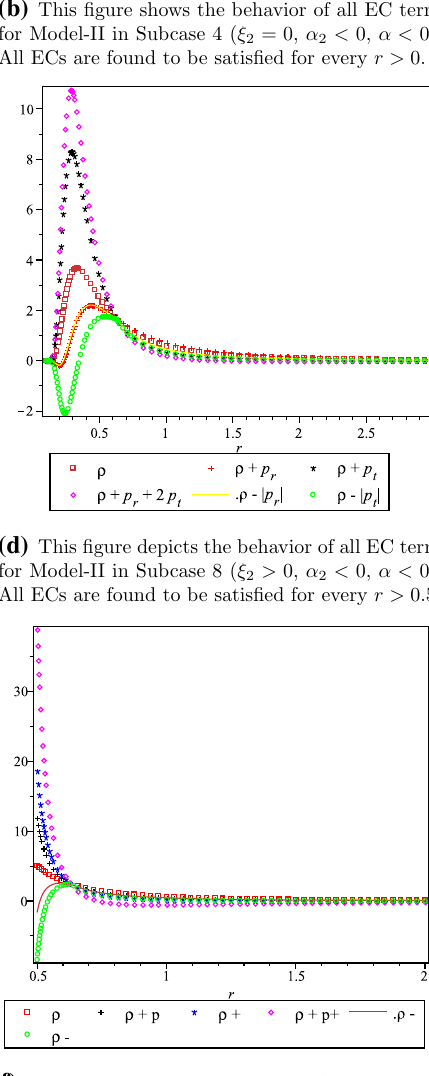
(f) This figure depicts the behavior of all EC terms for Model-II in Subcase 12 ( ξ 2 < 0, α 2 < 0, α < 0). All ECs are found to be satisfied for every r > 0 . 55.